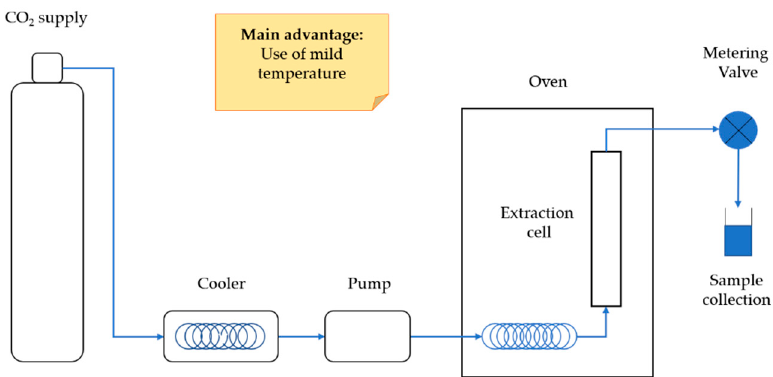
Figure 5. Schematic representation of typical SFE equipment.